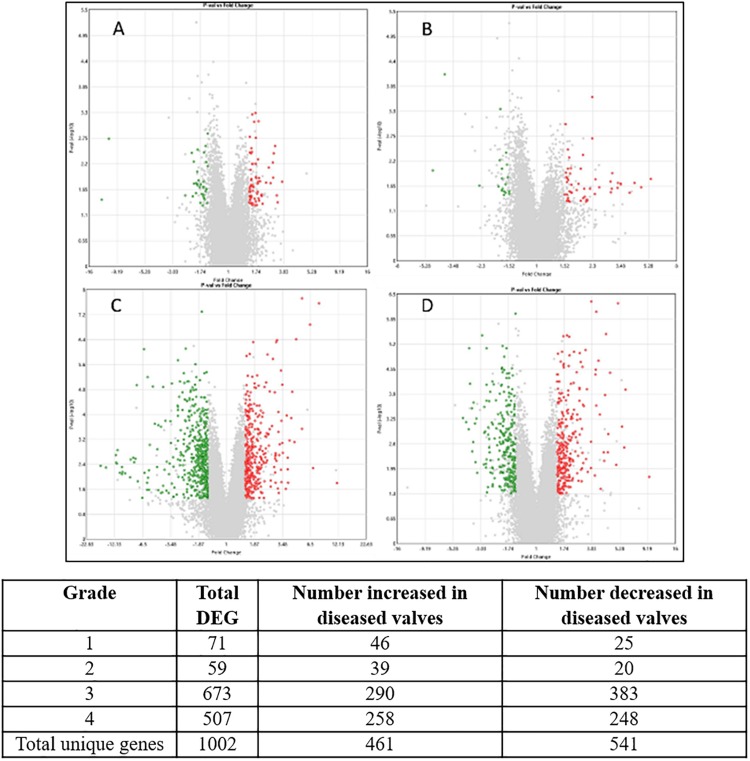
Volcano plots of each stage of disease compared against transcript expression in normal valves. (A) Grade 1; (B) grade 2; (C) grade 3; (D) grade 4. The X-axis shows fold change value and Y-axis shows the P-value. Central vertical line shows 0-fold change with negative fold changes relative to normal on the left and positive fold changes on the right. Red are transcripts up-regulated in the diseased valves (>1.5-fold) green are down-regulated transcripts (<−1.5-fold) and gray are transcripts which do not meet criteria for differential expression. Numbers for each category are shown in the table. Since some genes were differentially expressed in more than one comparison the totals for unique genes are lower than the sum of the individual comparisons.